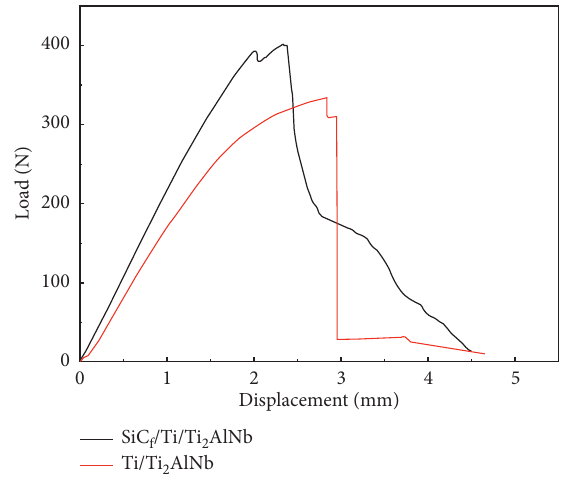
Figure 8: Load-displacement curves of the composite in the three- point bending test.